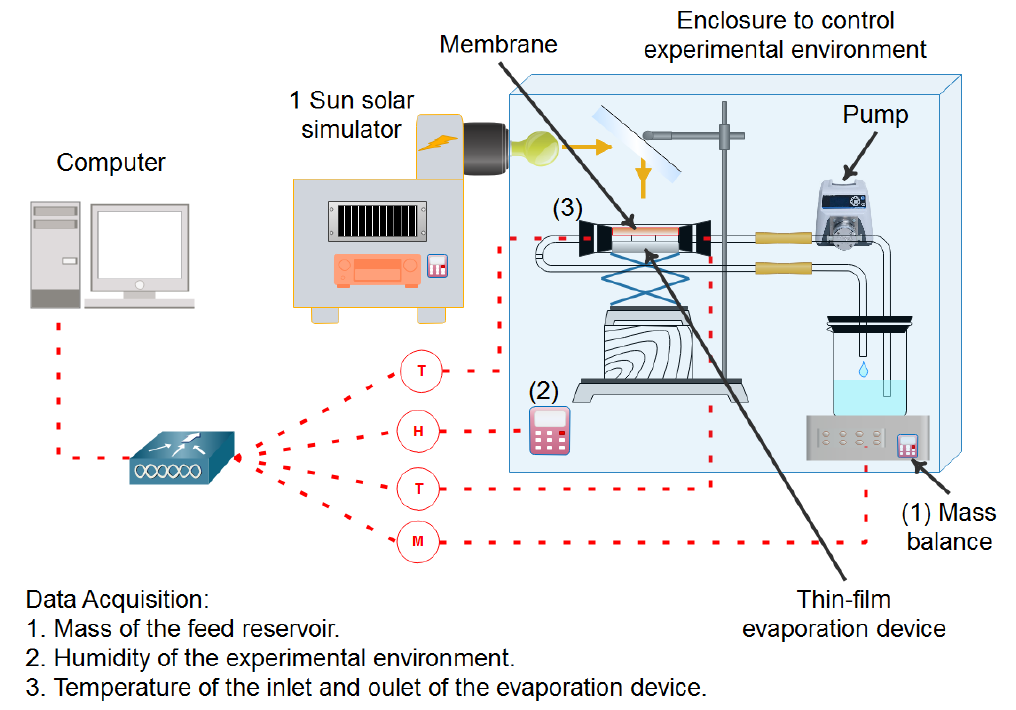
Figure 2. Schematic of the experimental setup illustrating the data acquisition and the connections of the device.